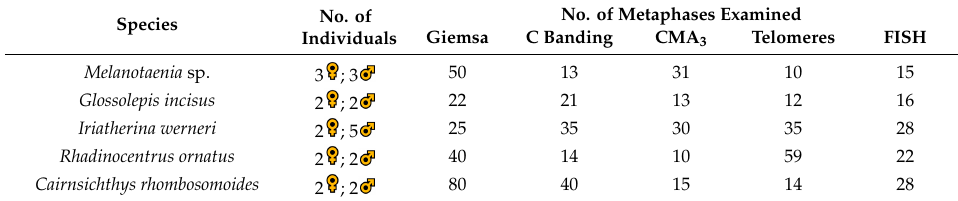
Table 1. Number of individuals and metaphases analysed in this study.